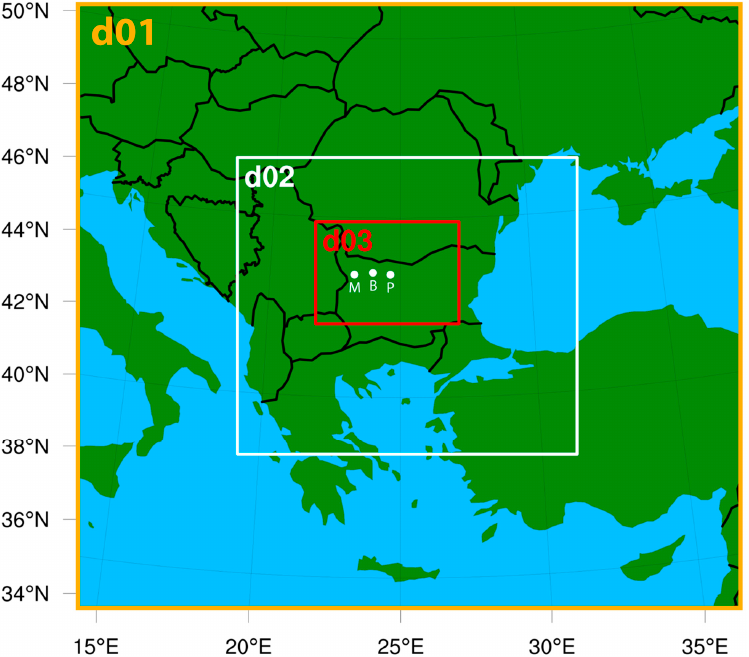
Figure 1. Position of the 9-km (d01), 3-km (d02) and 1-km (d03) Weather Research and Forecasting (WRF) model domains. The locations of the cities of Montana (M) and Pleven (P) and the town of Byala Slatina (B) have been marked with white dots as reference points.